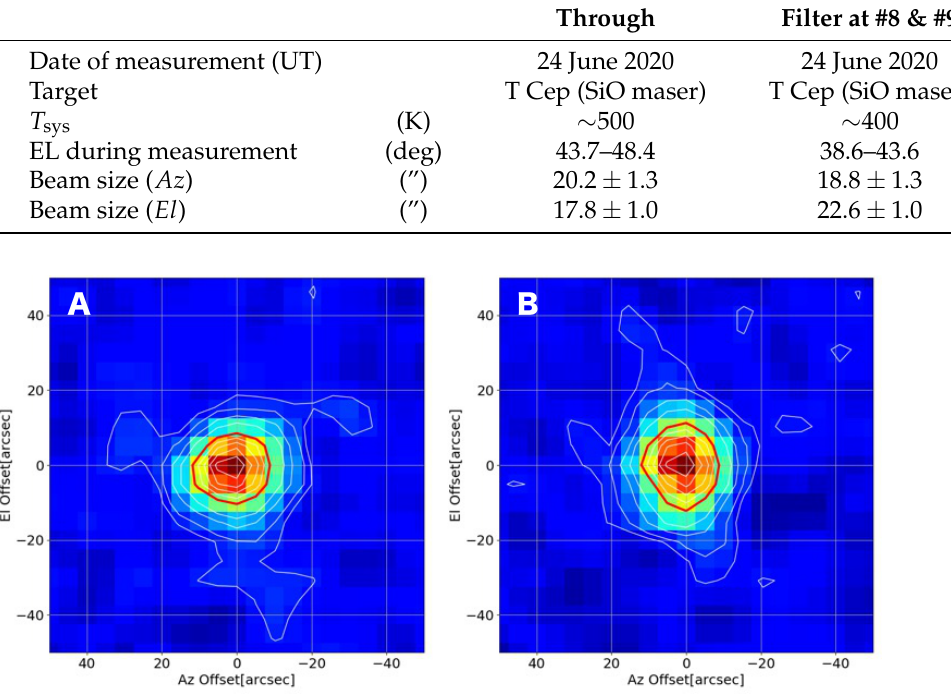
Figure 7. Beam pattern for vertical polarization obtained with the 86-GHz receiver system. No significant beam distortion was seen in either the Az or El direction, both with (panel A ) and without (panel B ) the frequency separation filter. The contours indicate 5, 10, 20, 30, 40, 50, 60, 70, 80, and 90% of the peak intensity.